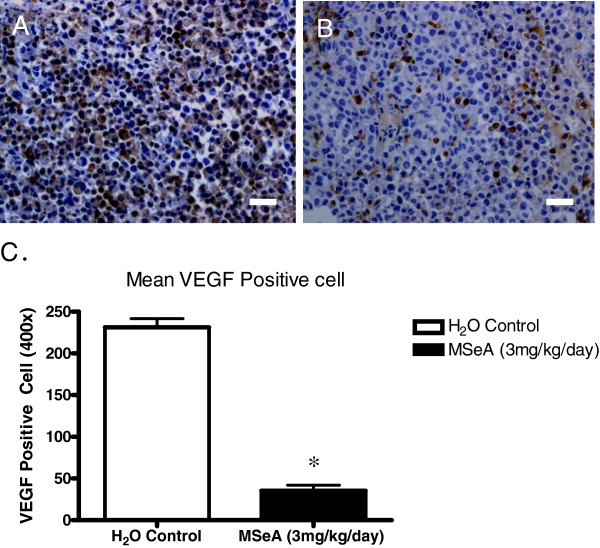
Immunohistochemistry (IHC) stain for VEGF showed a lower level of VEGF expression in the xenograft tumor from the animal received MSeA-treatment. A. Control. Target VEGF protein (brown cytoplasm) was extensively and highly expressed in a MDA-MB-231 cell-induced tumor of a representative nude mouse receiving no MSeA administration as control. B. MSeA treatment. VEGF protein expression was at a much lower percentage and level in xenograft tumor of a representative nude mouse receiving oral administration of MSeA at 3 mg/kg/day for 18 days. Scale bar = 50 μm. C. Statistical summary of VEGF positive cells for the control tumor (Mean = 234 cells/field, n = 3) and the MSeA treatment (Mean = 45 cells/field, n = 3) (P < 0.05).